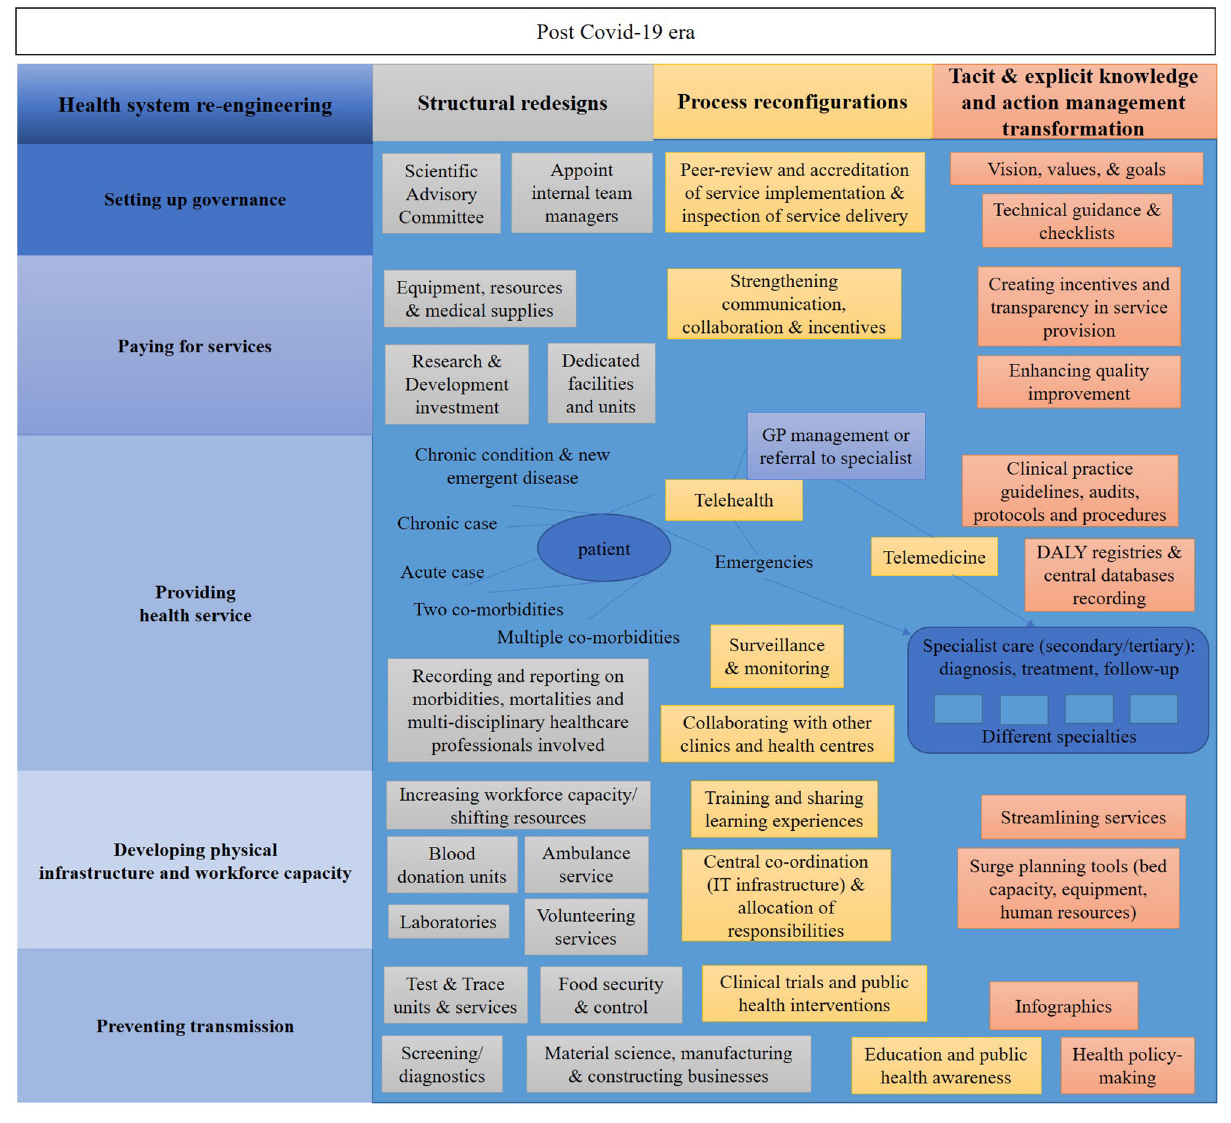
Frontiers in Public Health |